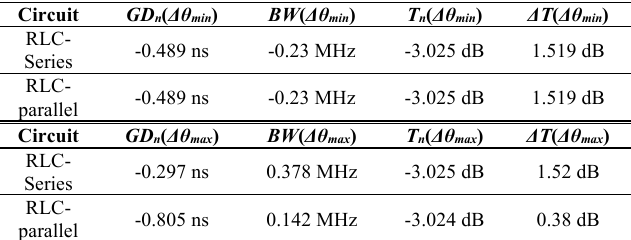
TABLE V. BP-NGD Specifications at the Minimal and Maximal Values of Temperature Stress Variation